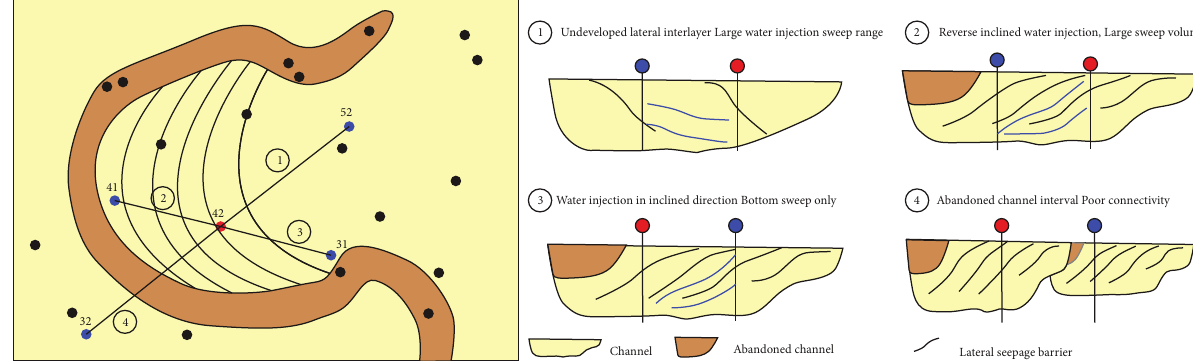
Figure 8: Comprehensive distribution pattern of seepage